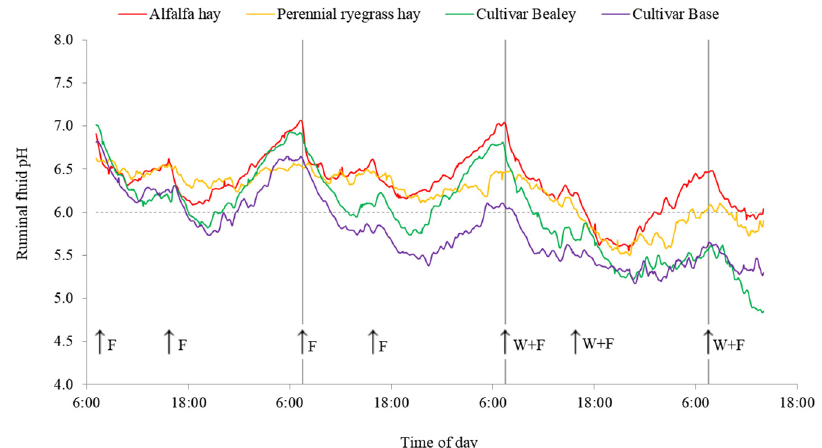
Figure 1. Changes in ruminal fluid pH over the 80-h measurement period for cows fed either lucerne hay, perennial ryegrass hay, perennial ryegrass herbage cultivar Bealey or perennial ryegrass herbage cultivar Base. Values are the raw means for treatments. Arrows indicate when feed was offered, F is a meal of forage only and WF is when wheat was fed followed by forage. The horizontal dashed line at pH 6.0 defines the ruminal fluid pH below which fibre digestion theoretically declines. The vertical lines indicate the beginning and end of each defined day. Table 4. Influence of forage type and the addition of wheat to the diet on mean ruminal fluid pH characteristics 1,2 . Forage Diet Mean Minimum Maximum Time under pH 6 3 Area under pH 6 4 Forage only Lucerne hay Forage Ryegrass hay